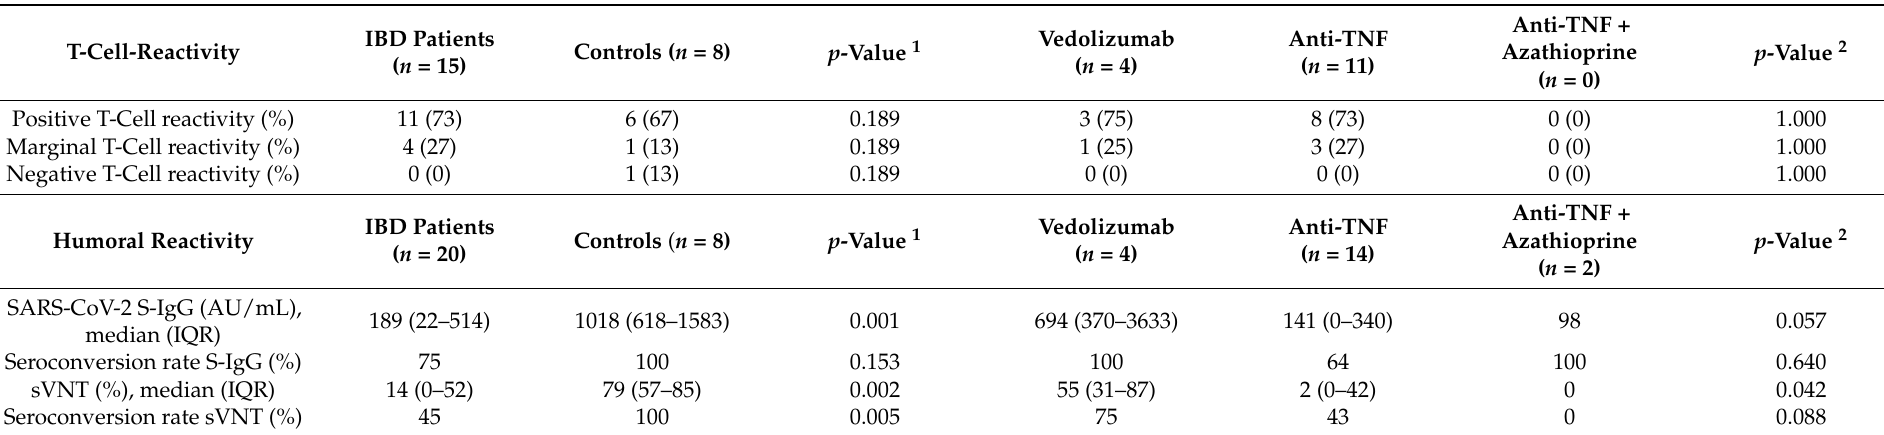
Table 2. T-cell reactivity, SARS-CoV-2 S-IgG levels, and sVNT values of IBD patients and healthy controls 6 months after the second vaccination. Partitioning of the IBD patient population was done based on immunosuppressive therapy: vedolizumab, Anti-TNF (adalimumab, infliximab), Anti-TNF + azathioprine. IBD: inflammatory bowel disease; IQR: interquartile range; p -value 1 : Mann–Whitney U test (Wilcoxon); p -value 2 :